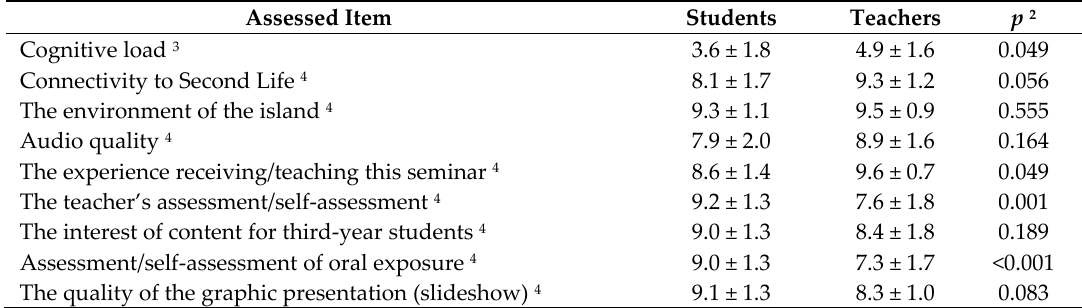
Figure 1. Screenshots during the radiology seminars: ( a ) Aerial view of the island where the seminars were held, specifically on the floating platform over the central area of the island. ( b ) Scene during one of the seminars given, in which students can be seen sitting in the open-air auditorium in front of the slide show screen while the teacher makes his presentation. Table 1. Results of the questionnaire about the experience 1